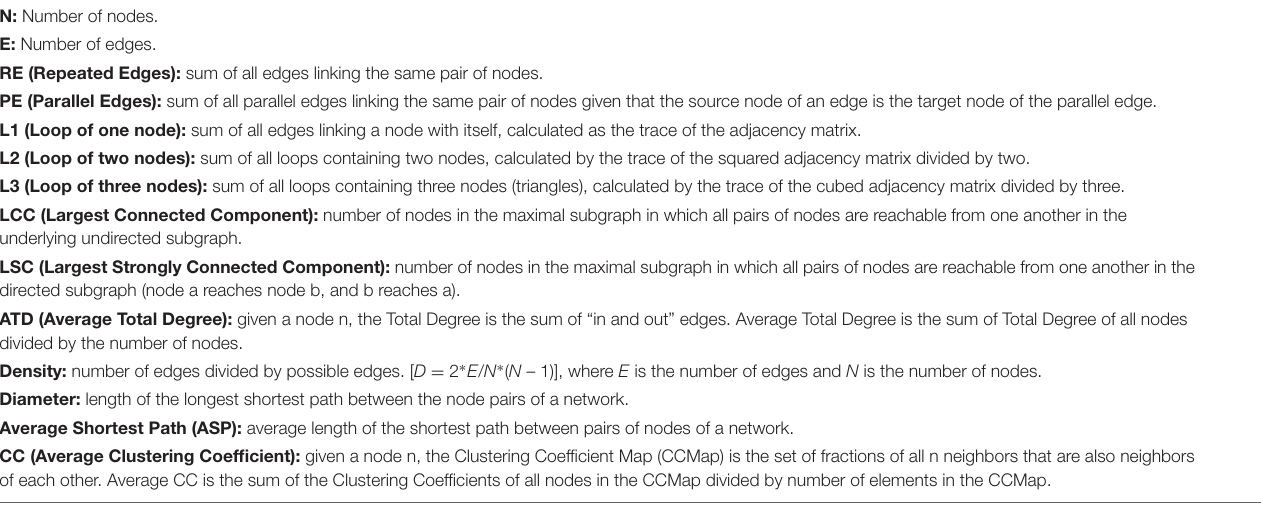
TABLE 2 | Speech graph attributes (SGA): detail description of each speech graph attribute measured from dream reports. N: Number of